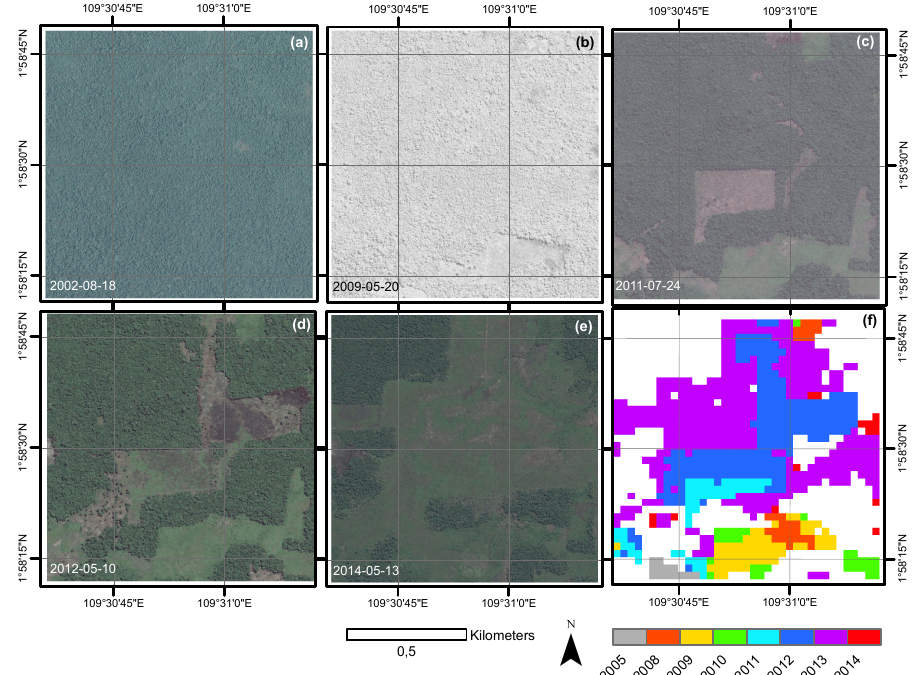
Figure 9. ( a )–( e ) Wall -to-wall application of the proposed deforestation detection algorithm with optimal (i.e., highest spatial accuracy) cons = 3 and k = 4 to a VHSR scene showing progressive forest loss. History noise removal was not applied. Deforestation map in ( f ) shows only the years (aggregated from the deforestation date, for visualization) when the algorithm detected deforestation in this scene. The dates of VHSR images were shown at lower left corner. The VHSR images were obtained through Digital Globe viewing service.